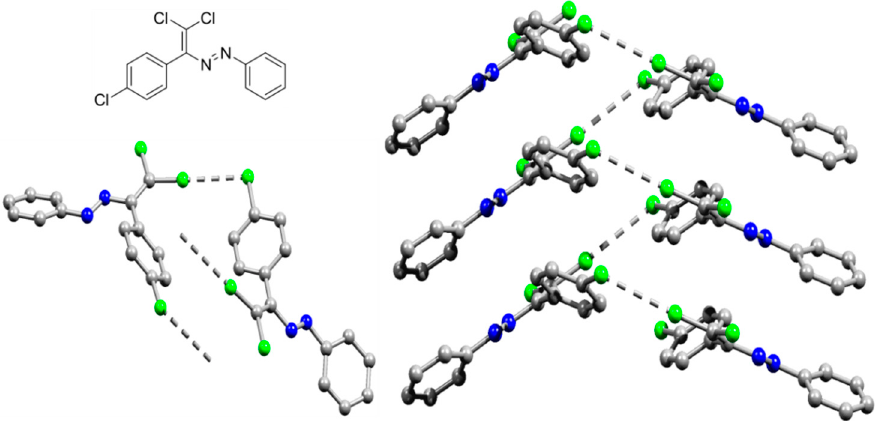
Figure 1. Ball-and-stick representation of 10 and its self-assembly via Cl···Cl bonding in the crystal. Blue, green and grey spheres represent nitrogen, chlorine, carbon atoms, respectively. Hydrogen atoms were omitted for clarity.